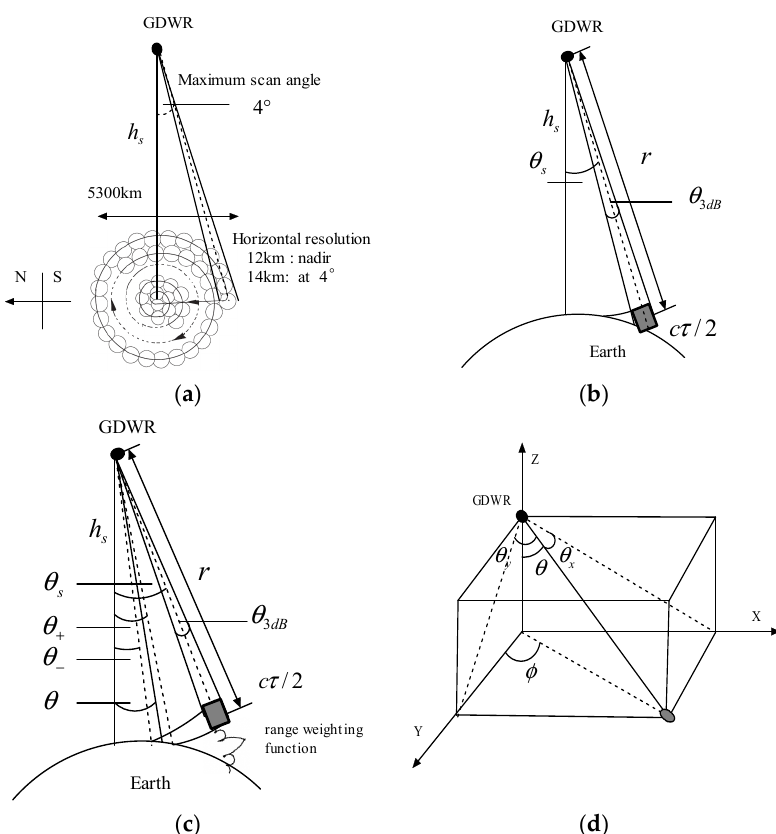
Figure 1. Geometry of the surface clutter interference in a geostationary spaceborne weather radar. The altitude of the geostationary orbit h s is 36,000 km and the scan angle θ s is from nadir to 4 ◦ . ( a ) Spiral scan mode; GSWR performs the spiral scan from nadir to 4 ◦ and its maximum horizontal resolution at 4 ◦ is nearly 14 km; ( b ) diagram of antenna mainlobe clutter; the grey square shows the radar range bin in which the antenna main beam has touched the earth surface; ( c ) diagram of the antenna sidelobe clutter and range sidelobe; the grey square shows the radar range bin in which antenna SL has touched the Earth’s surface, but the antenna main beam did not. It also shows the radar range bin that the range sidelobe will affect. ( d ) The geometry relation of incident angle θ , azimuthal angle φ with beam direction angles θ x , θ y